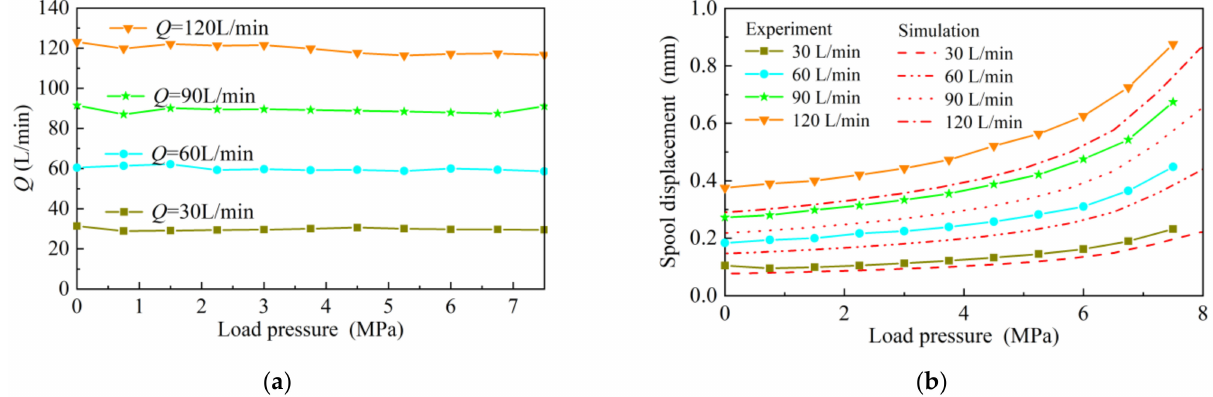
Figure 22. Load characteristic curve. ( a ) Flow curve under static load variation; ( b ) spool displace- ment curve under static load